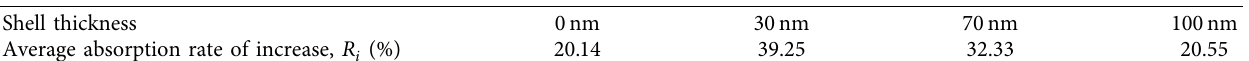
Table 1: The average absorption rate of increase for the shell thicknesses of 0nm, 30nm, 70nm, and 100nm of the CdS core-shell nanowires compared to a thin film. Shell thickness Average absorption rate of increase, R i